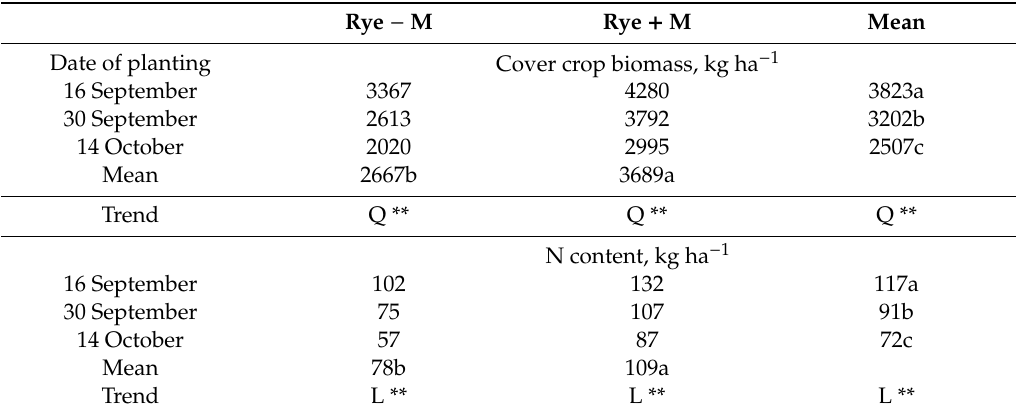
Table 2. Winter rye cover crop biomass prior to termination in spring and its total nitrogen content of shoots as a function of planting date and surface manure